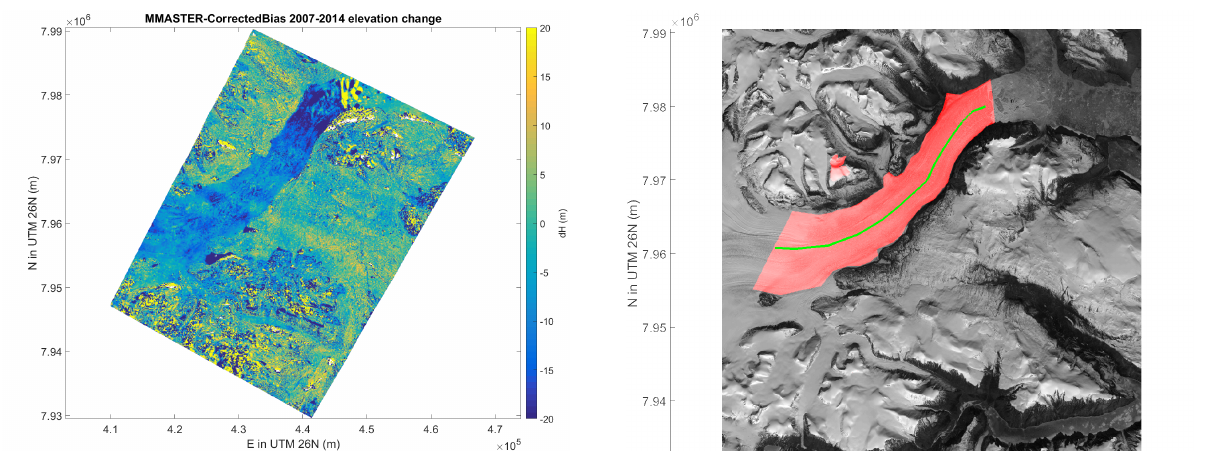
Figure 6: Example of measured elevation change after correction of the along-track jitter effect. Some jitter remains visible point- ing to a still imperfect correction. For an overview of the area covered see Figure 7.